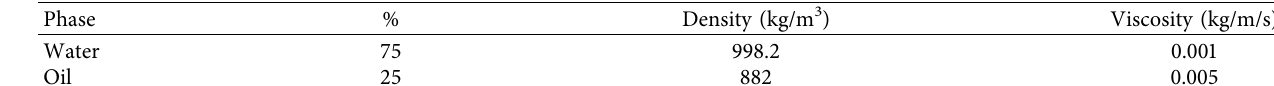
Table 2: Feed properties [42].